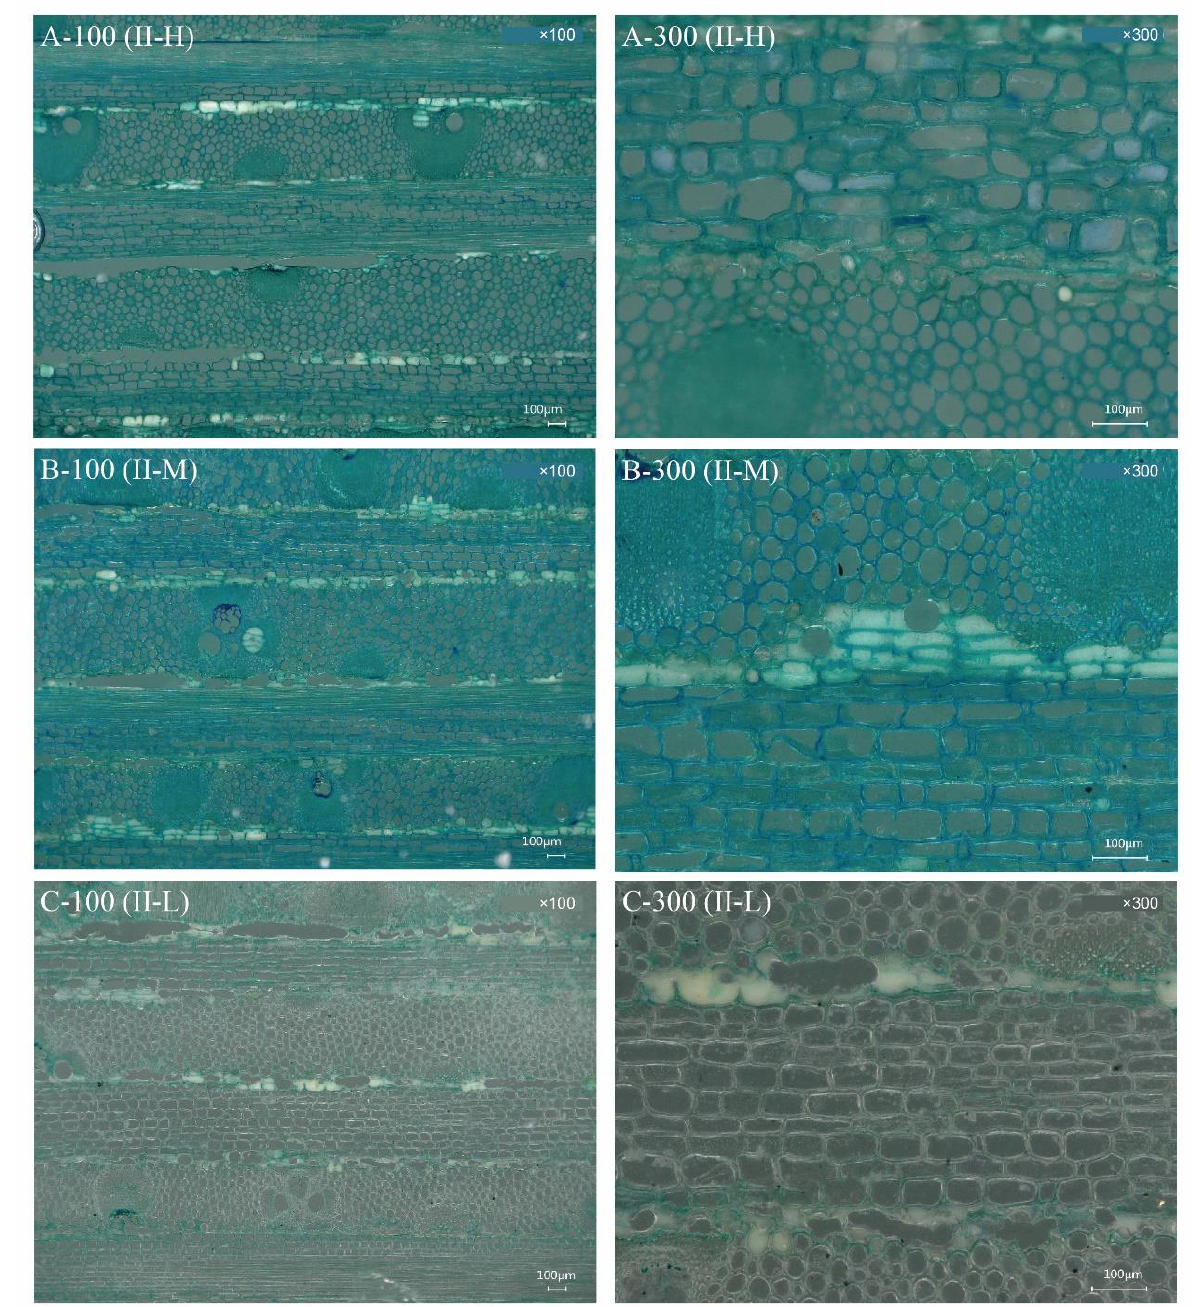
Figure 3. Photomicrographs of transverse sections of bamboo laminated composites of cross lamina- tion (type II). Resin penetration status of composites with varying fiber volumes. ( A – C ) denote types with high (II-H), medium (II-M), and low (II-L) fiber volumes, respectively; × 100 and × 300 represent magnifications; scale bar = 100 µ m. A-100, cross lamination with high fiber volume content com- posites at × 100 represent magnifications; A-300, cross lamination with high fiber volume content composites at × 300 represent magnifications; B-100, cross lamination with middle fiber volume content composites at × 100 represent magnifications; B-300, cross lamination with high fiber volume content composites at × 300 represent magnifications; C-100, cross lamination with low fiber volume content composites at × 100 represent magnifications; C-300, cross lamination with low fiber volume content composites at × 300 represent